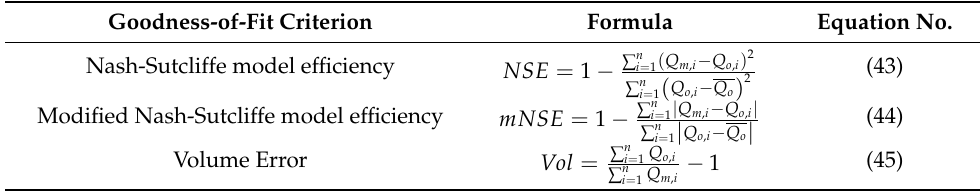
Table 3. Goodness-of-fit criteria under consideration. Goodness-of-Fit Criterion Formula Equation No. Nash-Sutcliffe model